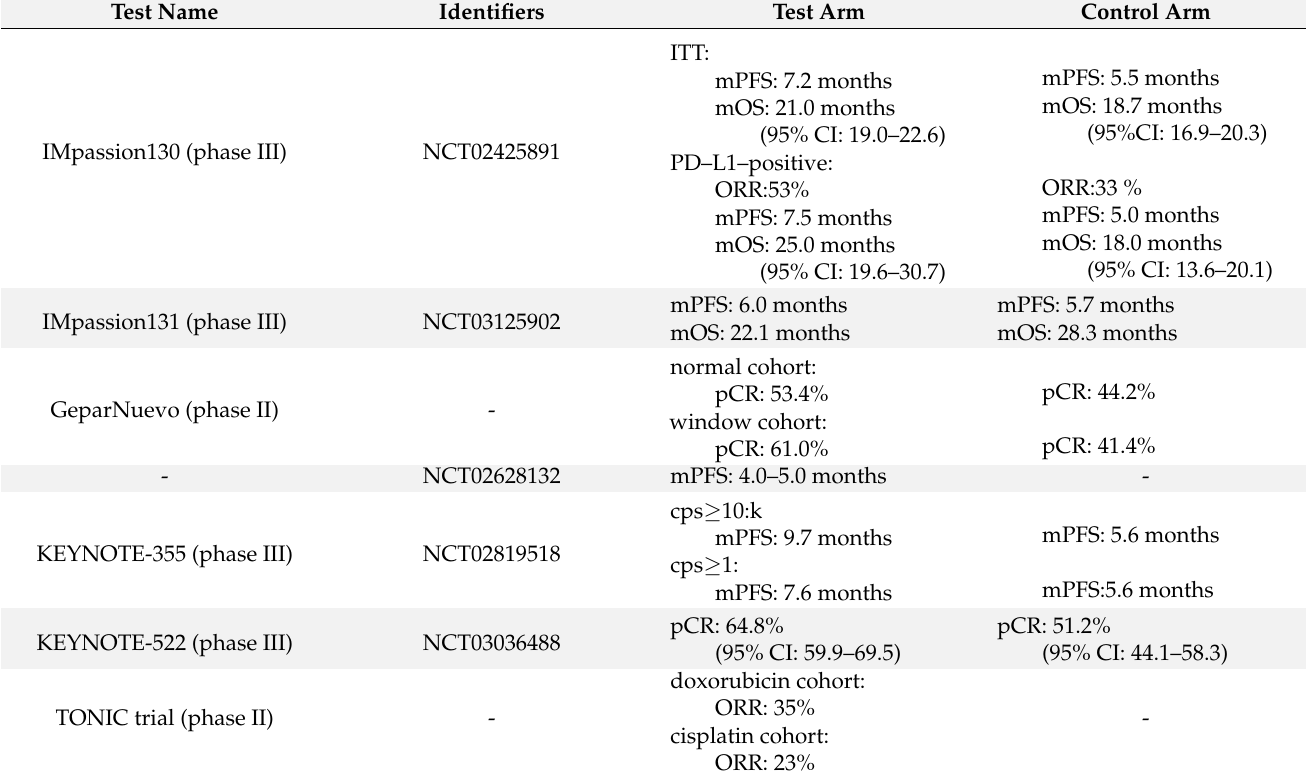
Table 5. Clinical trial results for PD- 1/PD-L1 inhibitors in combination with